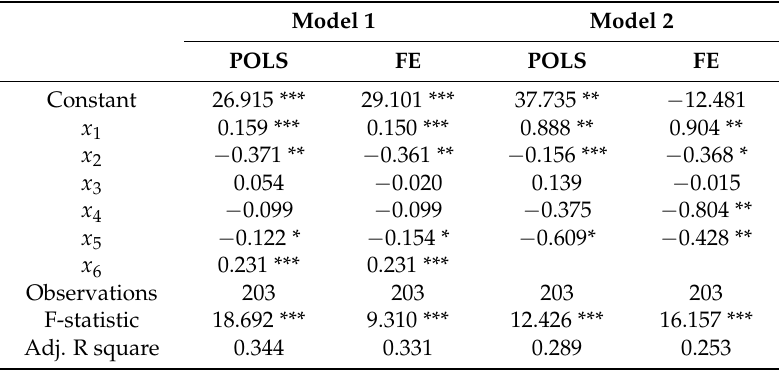
Table 4. Panel data regression coefficients for the determinants of energy